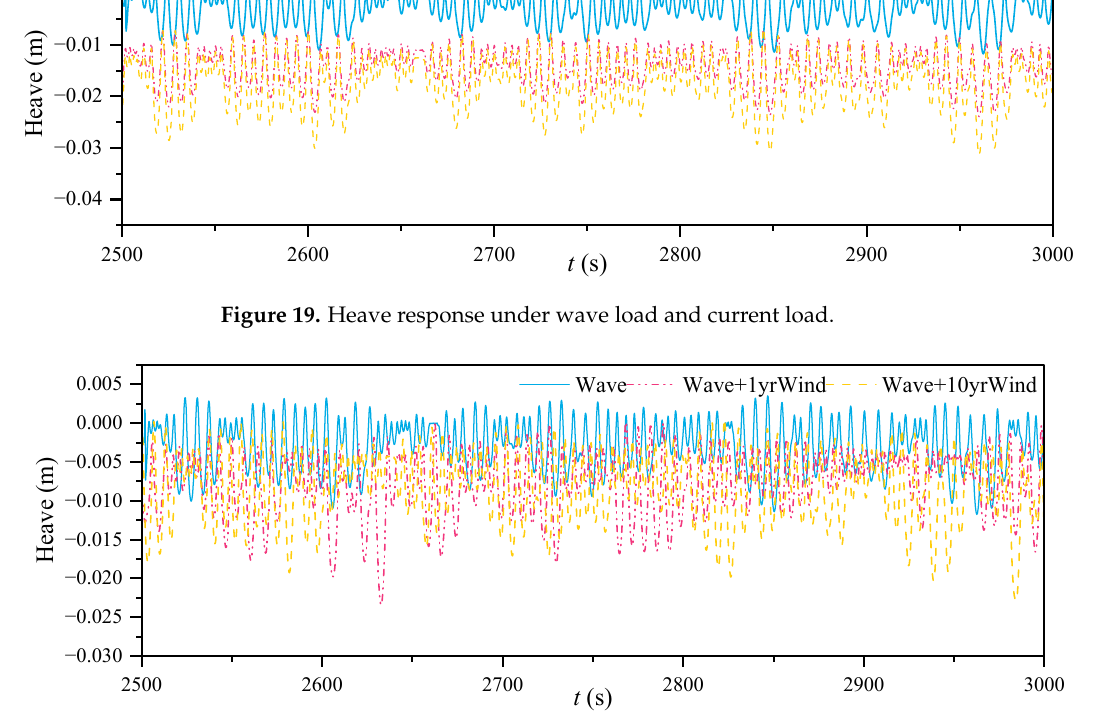
Figure 20. Heave response under wave load and wind load.